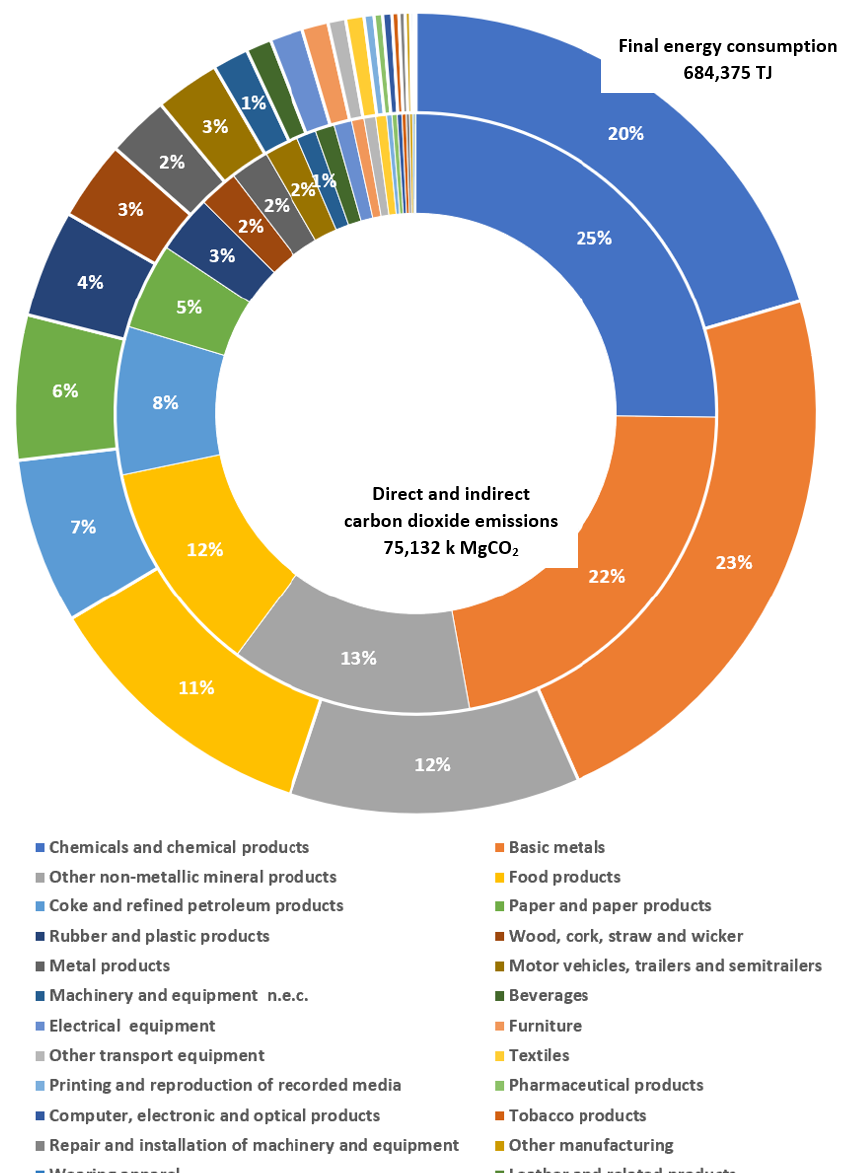
Figure 5. The share of individual industries in the final energy consumption (outer ring) and carbon dioxide emissions (related to energy consumption, inner ring) in 2019 in Poland (own study based on National Centre for Emissions Management annual reports [42,43] and Statistics Poland reports [37]).